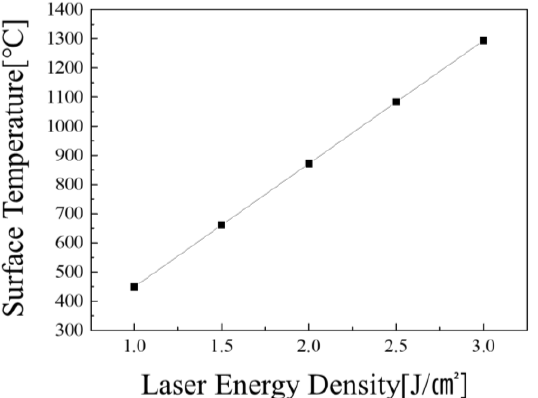
Figure 2. The surface temperature simulation of energy density (provided by SHI).